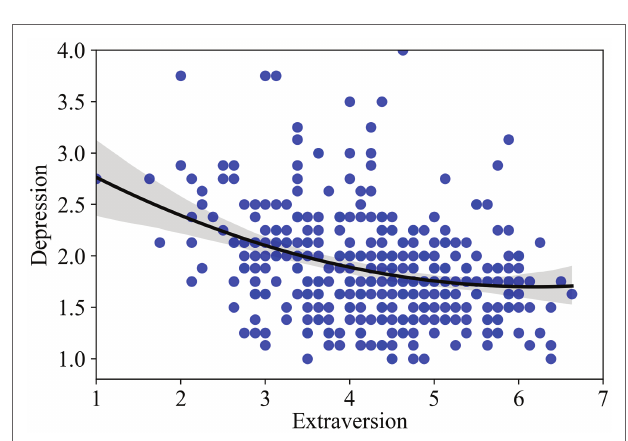
FIGURE 3 | Curvilinear relationship between extraversion and